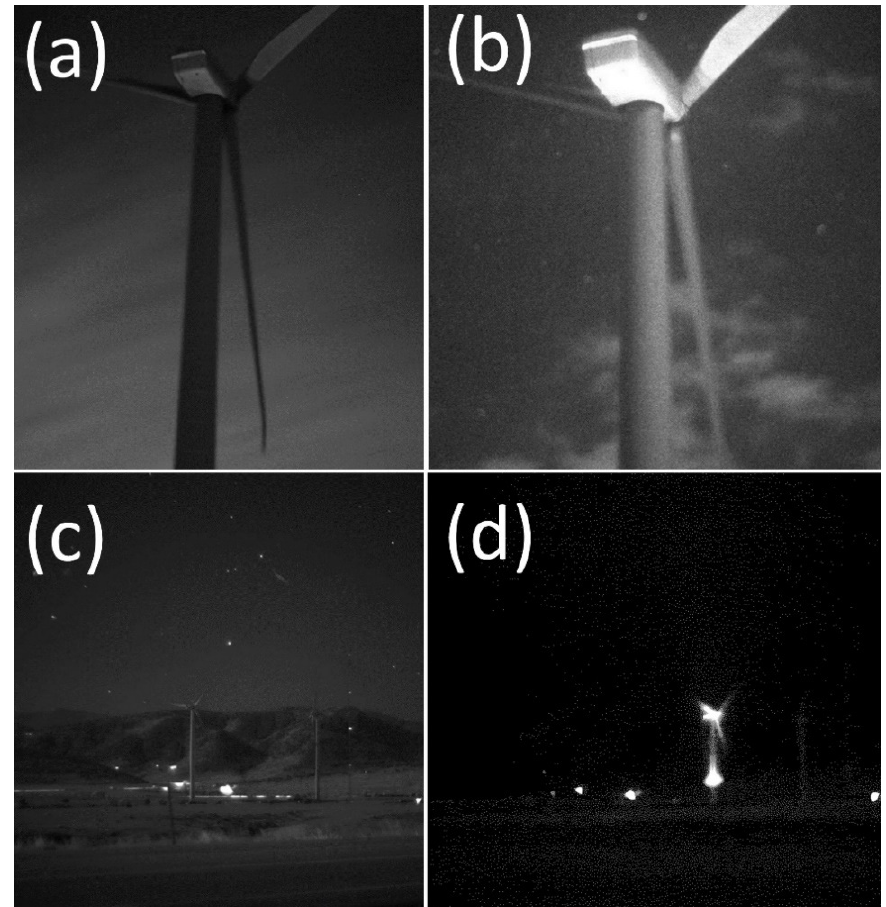
Figure 5. Nighttime images of wind turbines imaged with UV-sensitive cameras. Images of wind turbine captured from 60 m away with a high-sensitivity, scientific-grade camera without UV illu- mination ( a ) and with illuminator system turned on ( b ). Panels ( a – c ) show nighttime images through a light filter that blocked visible parts of the spectrum (~400–700 nm) but allowed both UV and near-infrared wavelengths (~700–800 nm) to pass. Bottom row shows turbines imaged from approximately 1.5 km to the northeast with both turbines with UV illumination and through the filter that allowed passage of UV and near-infrared wavelengths ( c ), and the same scene with the North Turbine (right) UV-illuminated and through a filter that allowed only UV wavelengths to pass and blocked all infrared and visible wavelengths ( d ). Images by Paul Cryan.